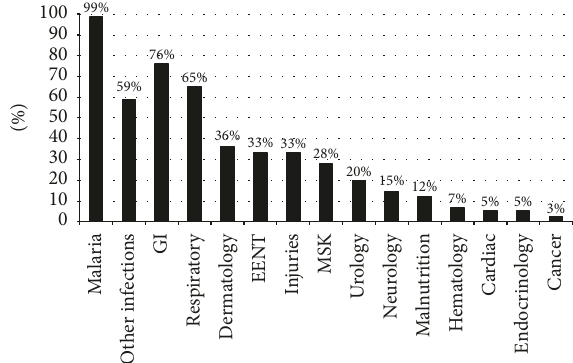
Figure 1: Range of illnesses treated at unlicensed drug outlets ( 𝑛 = 75 ). Drug vendors provided multiple responses. GI: gastrointestinal illnesses; EENT: eyes, ear, nose, and throat illnesses; MSK: muscu- loskeletal illnesses.